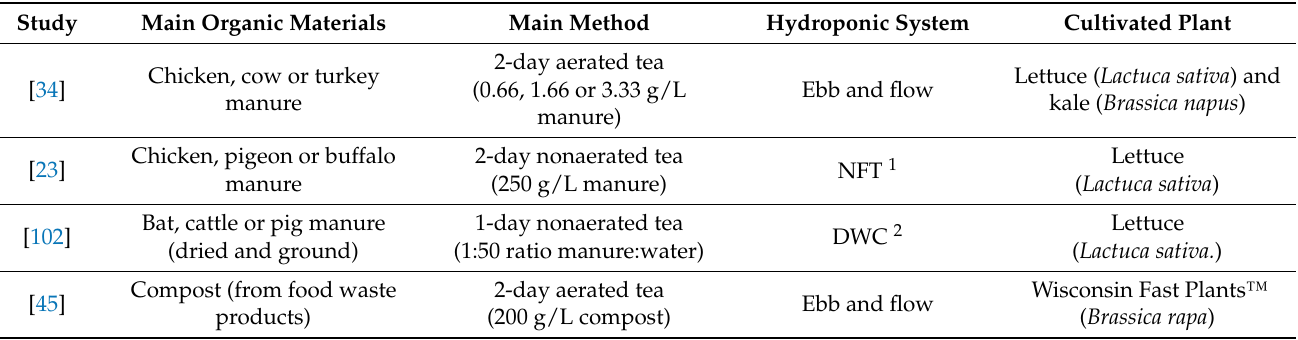
Table 3. Main organic materials and method of tea for the production of nutrient solution used in different types of